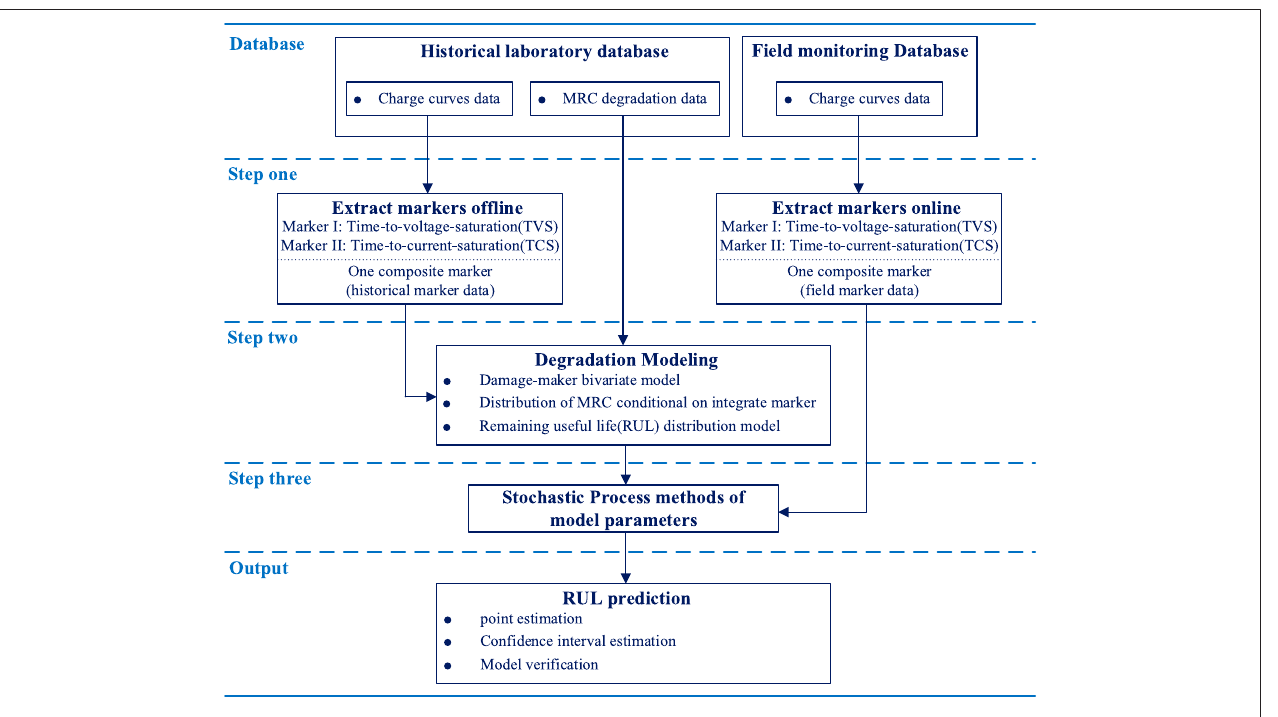
FIGURE 7 | The framework of RUL prediction for stochastic process